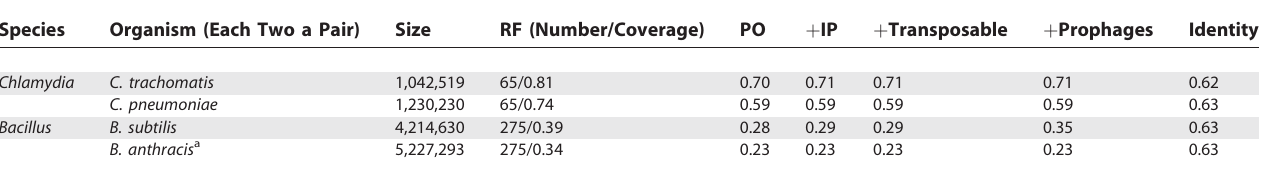
Table 6. Comparing Distantly Related Bacteria Pairs Species Organism (Each Two a Pair)